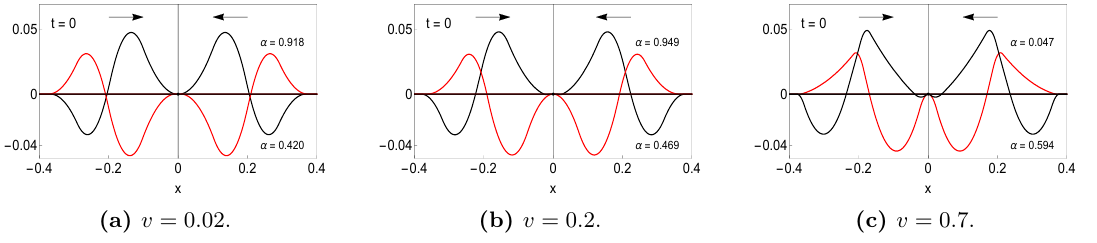
Figure 29 . Initial con(cid:12)gurations that minimize the radiation for V = 0 :